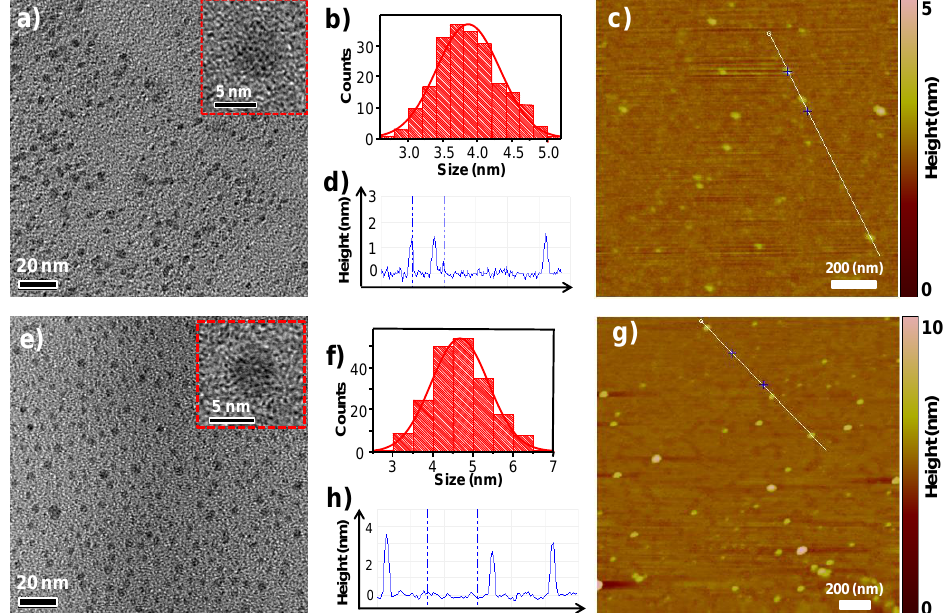
Figure 3. ( a ) TEM and high resolution TEM images of the g-CDs; ( b ) Size distribution of the g-CDs based on the TEM; ( c ) AFM image of the g-CDs; ( d ) height-profile analysis of the g-CDs along the line in (c); ( e ) TEM and high resolution TEM images of the r-CDs; ( f ) Size distribution of the r-CDs based on the TEM; ( g ) AFM image of the r-CDs; ( h ) height-profile analysis of the r-CDs along the line in (g).